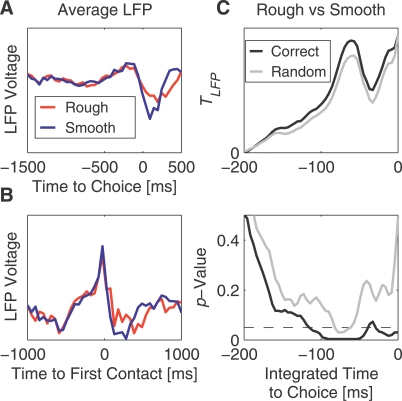
Texture Coding in Local Field Potential (LFP)(A) LFP curves aligned on moment of choice and averaged across trials.(B) LFP curves aligned on moment of first touch of any whisker.(C) Upper panel: LFP Texture Index TLFP on correct trials only compared to random trials, integrated across backwards-growing windows from the moment of choice to −t. Lower panel: significance of TLFP being greater than chance on correct trials (black trace) and significance of TLFP being greater on correct trials compared to random trials (gray trace). For both, p < 0.05 for t = −75 ms.